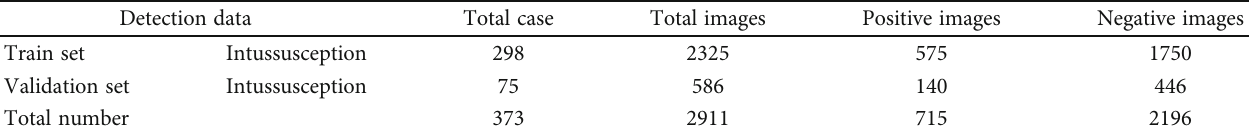
Table 2: Division of detection data.